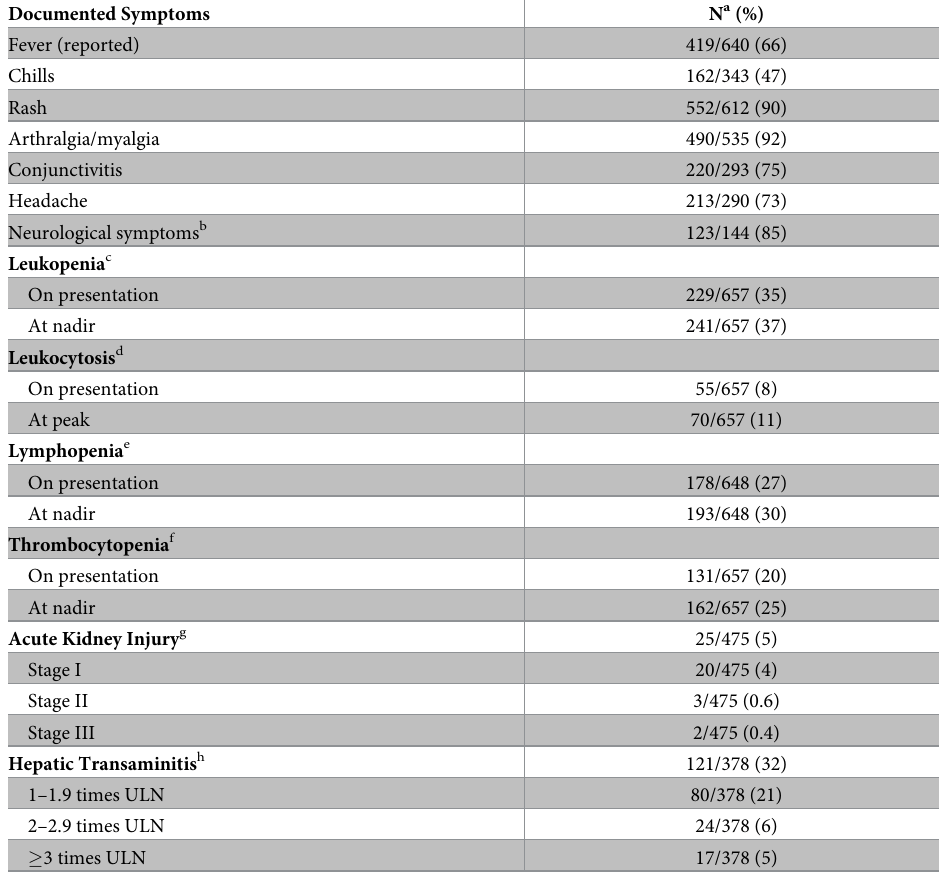
Table 2. Documented symptoms, signs and laboratory abnormalities of patients with ZIKV